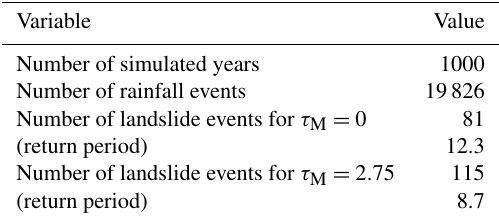
Table 2. Some characteristics of the ideal Monte Carlo simulation